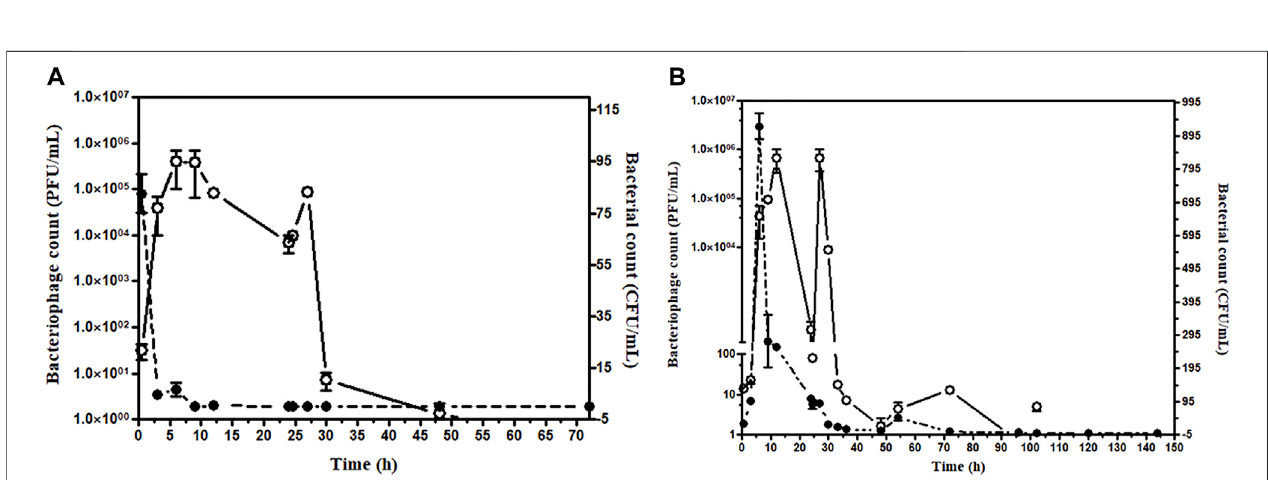
FIGURE6|(A) Assessment ofbacterialand bacteriophage countinthemicebloodafter simultaneousinjection. Thebacterialchallenge given8×10 7 CFU/mouse and bacteriophage 1 × 10 5 PFU/mouse, Open circle ( ○ ) denotes PFU/mL, and the closed circle ( count in the mice blood up to 144 h bacteriophage cocktail was given 6 h after bacterial challenge. The bacteriophage cocktail was given daily for 5 days. The bacterial challenge given 8 × 10 7 CFU/mouse and bacteriophage 1 × 10 5 PFU/mouse. Open circle ( ○ ) denotes PFU/mL, and the closed circle (